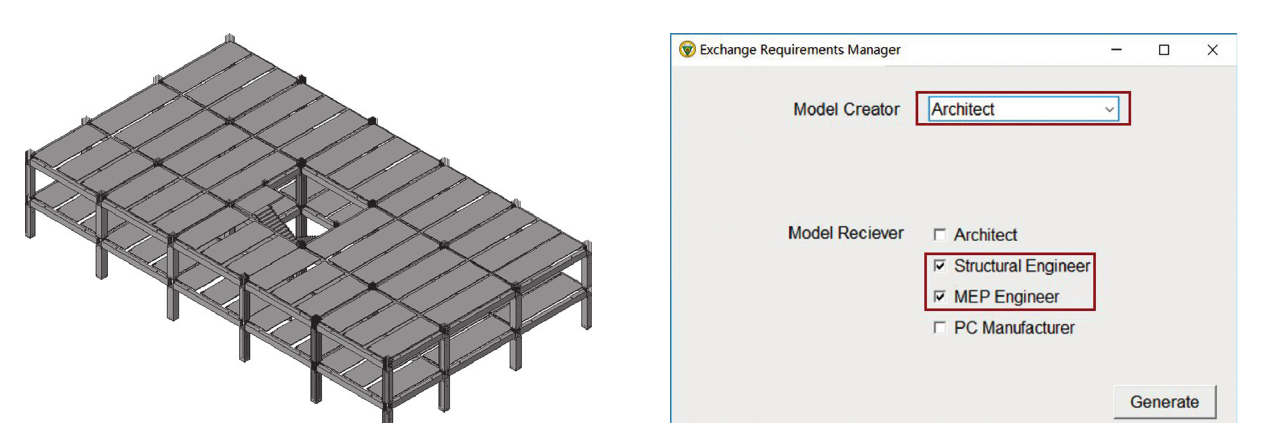
Figure 16: Implementation process.